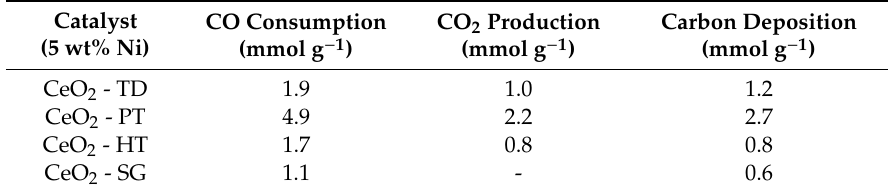
Table 2. Quantity of CO consumption and CO 2 formation (mmol g − 1 ) obtained after 30 min 20% CO/He at 750 °C. Also shown is the amount of carbon deposition (mmol g − 1 ) obtained after TPO following 30 min of CO disproportionation.